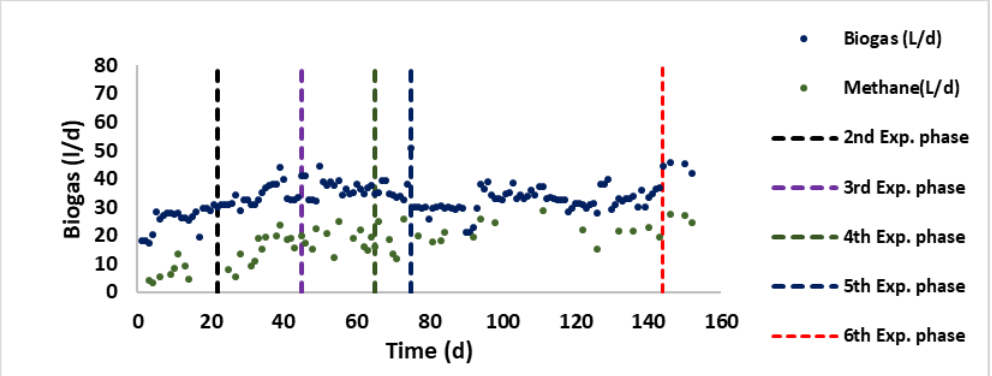
Figure 2 . Daily biogas and biomethane production of PABR. Figure 2. Daily biogas and biomethane production of